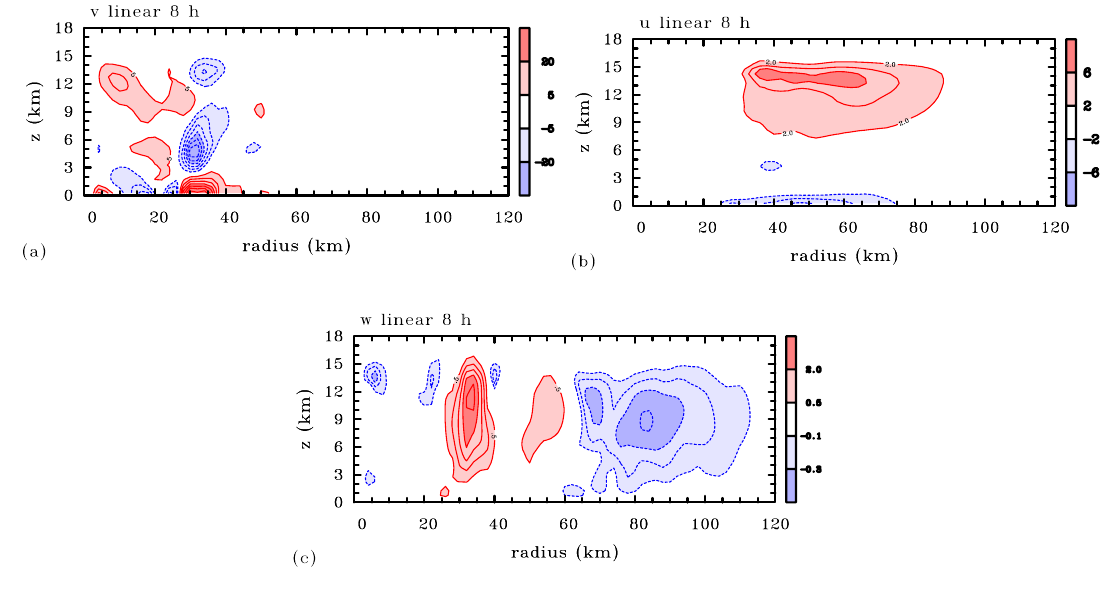
Figure 3. Output from the linear 3DVPAS model at 8 h integration time. Shown in a radius-height coordinate system are ( a ) tangential velocity disturbance v 0 (contour interval every 5 m s − 1 ; dashed negative, solid positive); ( b ) radial velocity disturbance u 0 (contour interval 2 m s − 1 ; dashed negative, solid positive); ( c ) vertical velocity disturbance w 0 (positive contour interval 0.5 m s − 1 , solid; negative contour interval 0.1 m s − 1 ,